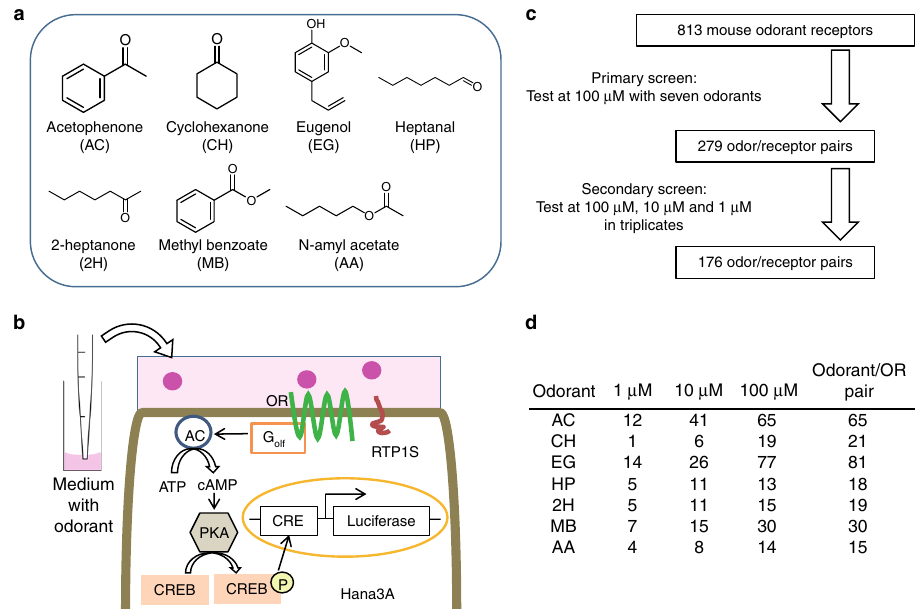
Fig. 1 A large-scale screening to identify OR-odorant pairs. a Odorants tested in the assay. b Schematic representing the luciferase reporter gene assay in Hana3A showing OR signal transduction pathway. c Outline of the screening procedure. d The number of ORs that passed the secondary screen for each odorant ( t -test, p < 0.05 uncorrected). AC adenylyl cyclase, ATP adenosine triphosphate, cAMP cyclic monophosphate, CRE cAMP response element, CREB cAMP response element binding protein, PKA protein kinase A, RTP1S receptor transporting protein 1